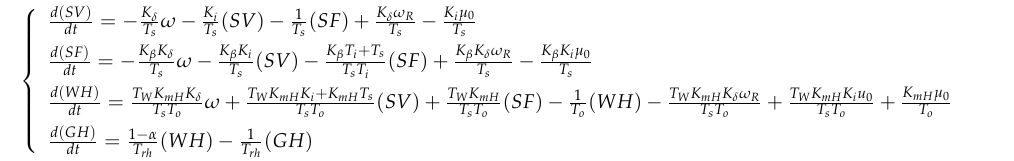
Figure 2. Governor model.